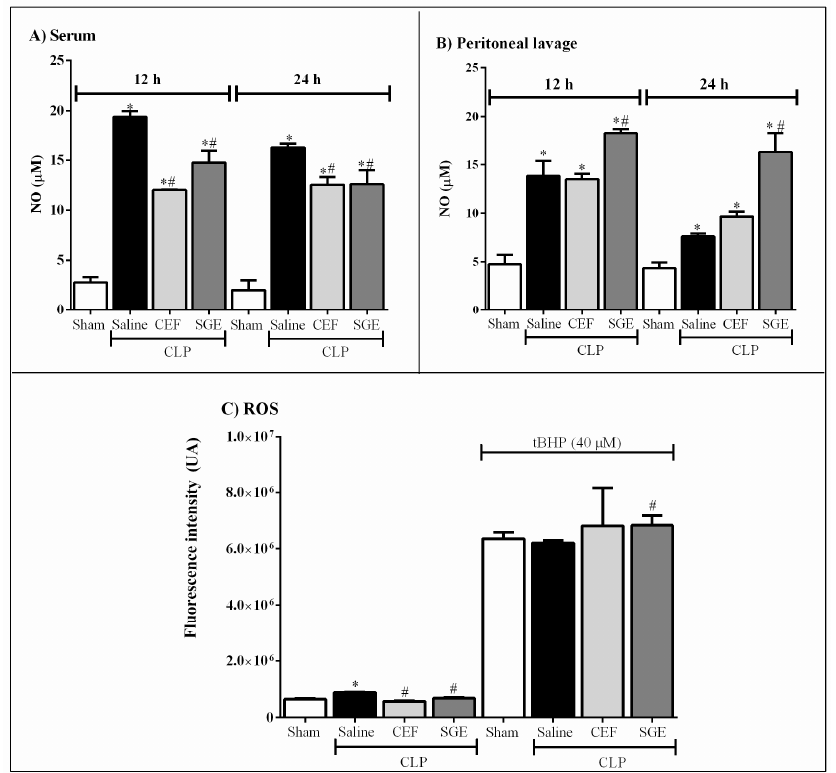
Figure 4. Effect of SGE on NO and ROS production in septic mice. ( A ) NO levels in serum 12 h and 24 h after CLP; ( B ) NO levels in the peritoneal cavity 12 h and 24 h after CLP; ( C ) ROS production by peritoneal macrophages stimulated or not with 40 μ M t-BHP. The results were expressed as the mean ± SD (five animals/group). * p < 0.05 compared to sham control group; # p < 0.05 compared to the saline control group. CLP: cecal ligation and puncture; SGE: salivary gland extract; CEF: ceftriaxone; NO: nitric oxide; ROS: reactive oxygen